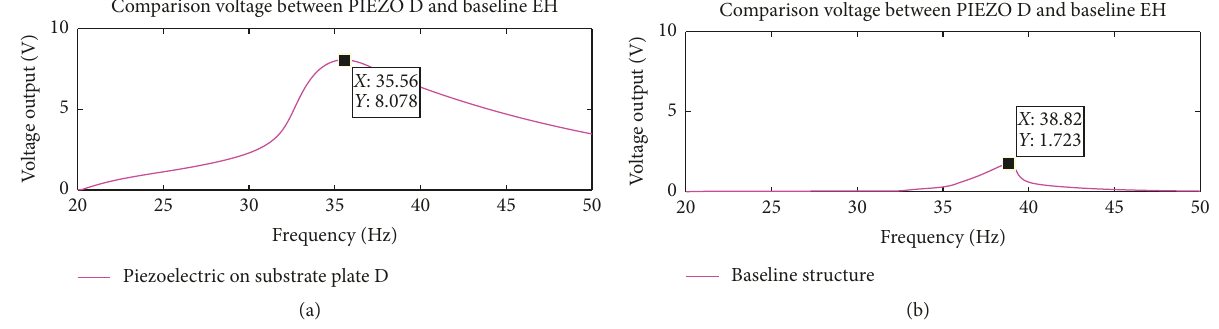
Figure 13: Voltage responses of PIEZO D and baseline EH (PIEZO D: the piezoelectric on substrate plate D; baseline EH: the baseline energy harvester).